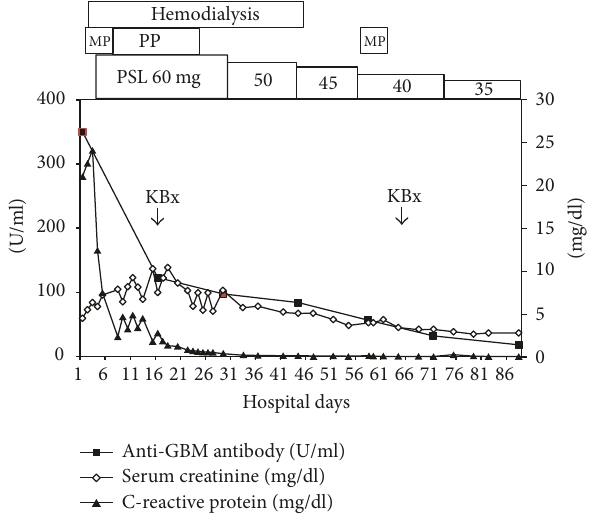
Figure 1: Clinical course. MP, methylprednisolone pulse therapy (1g per day for 3 successive days); PP, plasmapheresis 7 times; PSL, prednisolone; KBx, kidney